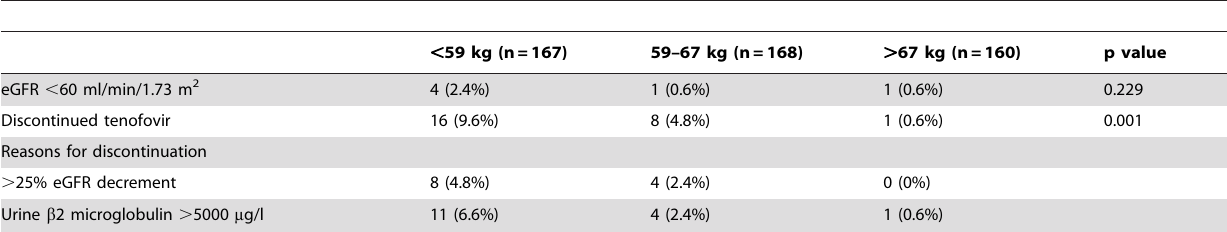
Table 6. Number of patients whose eGFR decreased to , 60 ml/min/1.73 m 2 and who discontinued tenofovir with clinical diagnosis of renal dysfunction due to